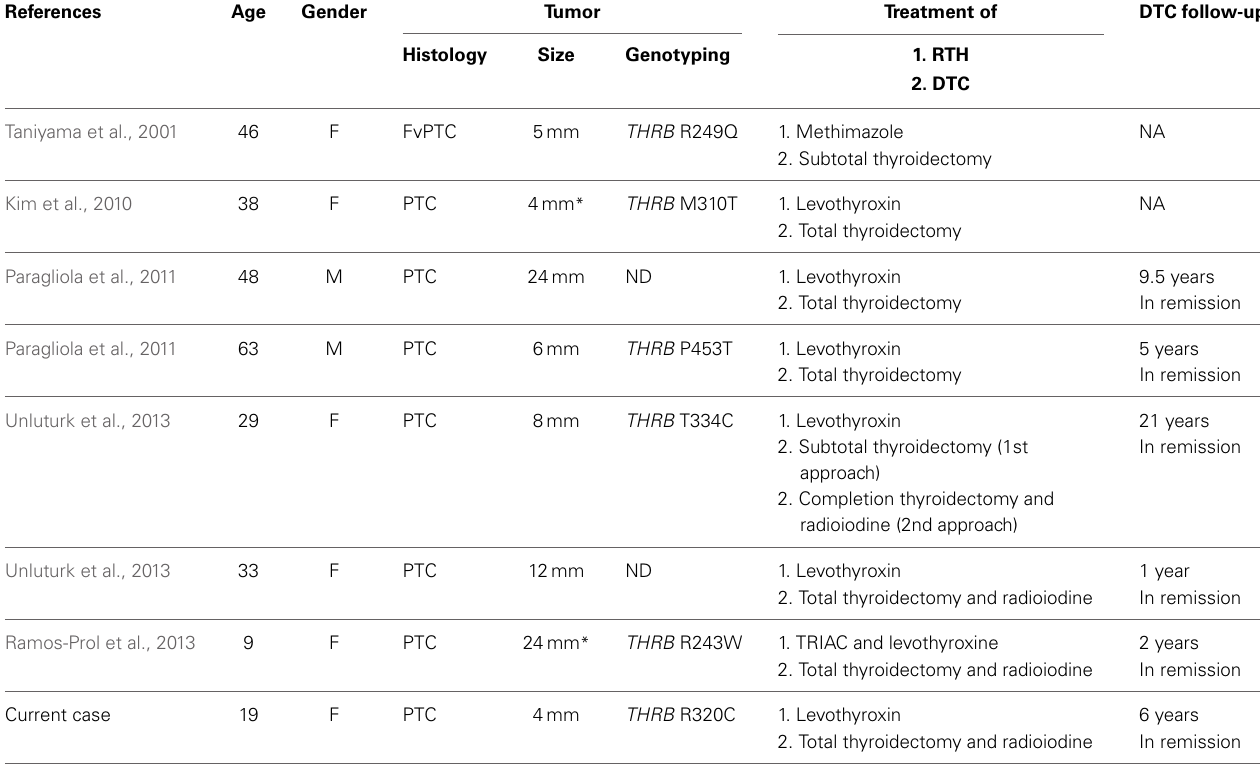
Table 1 | Review of known cases of RTH patients with differentiated thyroid